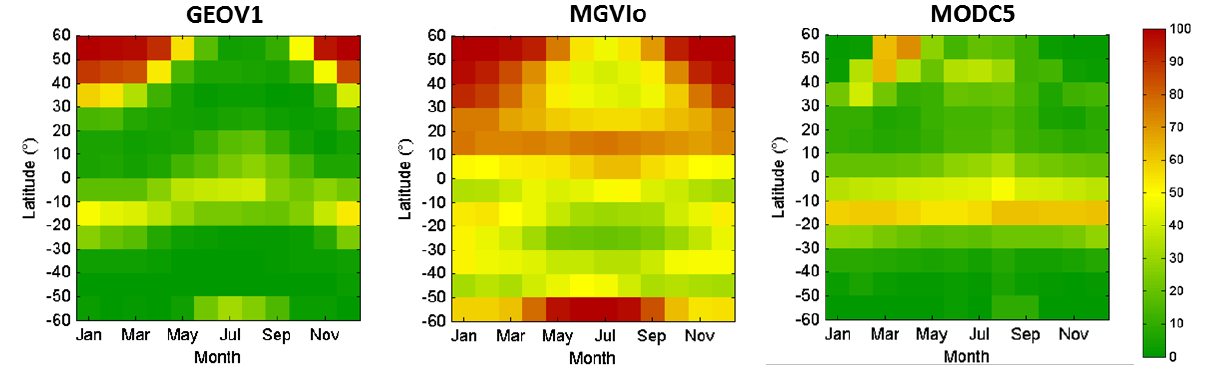
Figure 3. Spatio-temporal distribution of the fraction of invalid products for GEO, MGVIo and MOD.C5 products. For MODIS, the backup algorithm (QA = 2) is included. Computation is performed over the BELMANIP2.1 sites (49 × 49 km 2 ), during the periods defined in Table 2, and for the original temporal